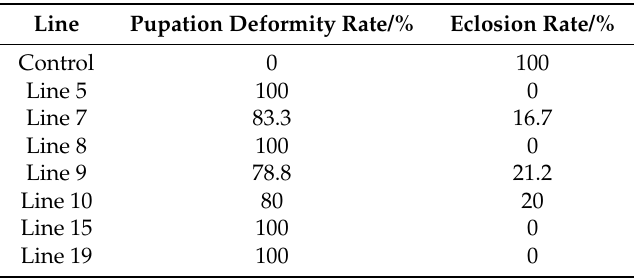
Figure 4. Deformed development of H. armigera at the metamorphosis stage. ( a ) Phenotype of the 3rd-instar larvae; ( b ) phenotype of the 5th-instar larvae. The control group was fed with male parent F15 cotton; treatment groups were fed with transgenic cotton. Table 1. The pupation deformity and eclosion rate of H. armigera development.